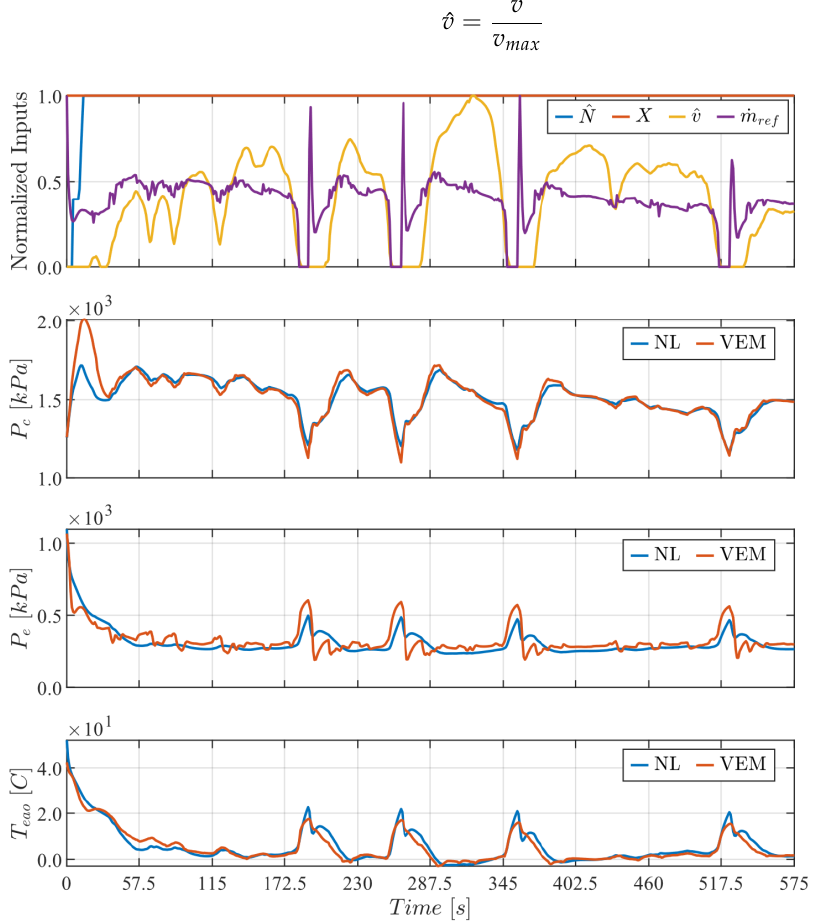
Figure 3. VEM and NL pressure and temperature comparison for SC03 cycle.